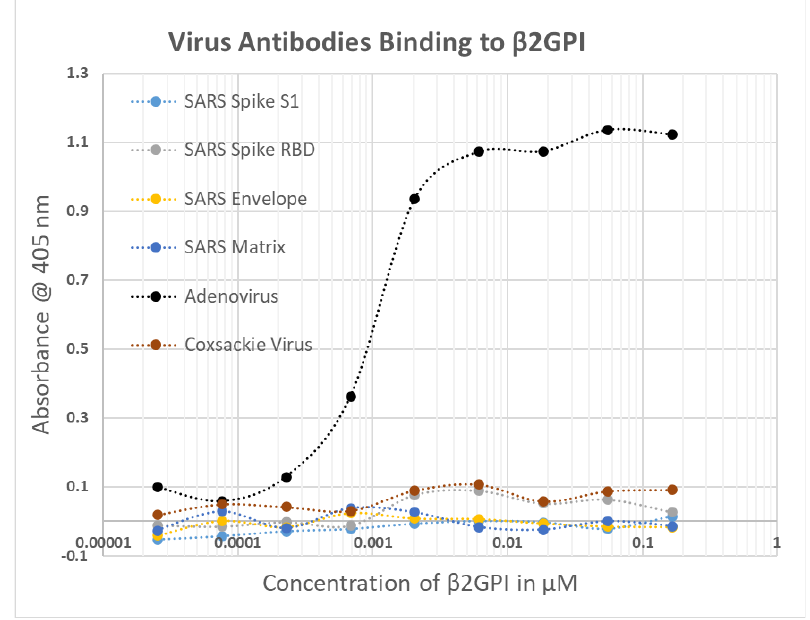
Figure 5 . SARS-CoV-2 (spike S1, spike RBD, envelope, matrix), adenovirus and coxsackie Virus (type B) antibody binding to beta 2 glycoprotein I (β2GPI). These are the results of a single experi- ment, which is why there are no error bars. Results were confirmed in by separate replication.